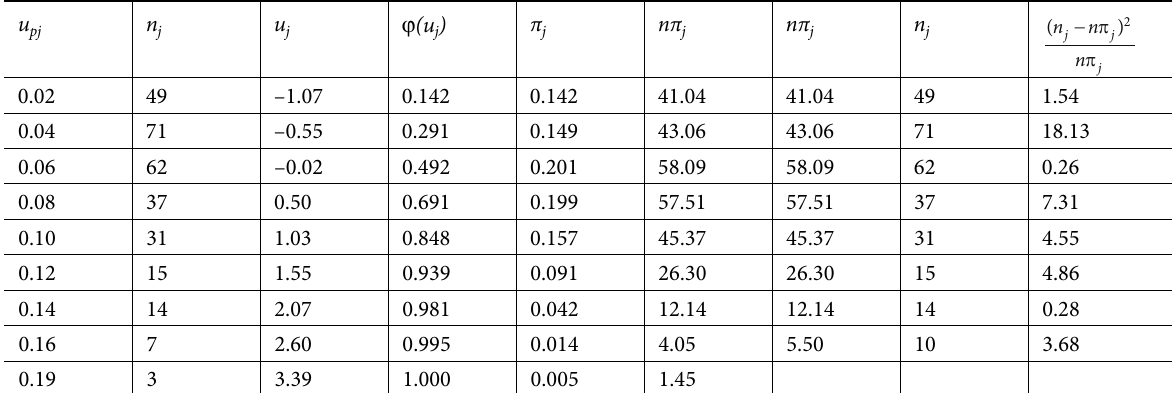
Table 4. Calculation schema of test statistic χ 2 for positional deviations in Přívoz cad. district